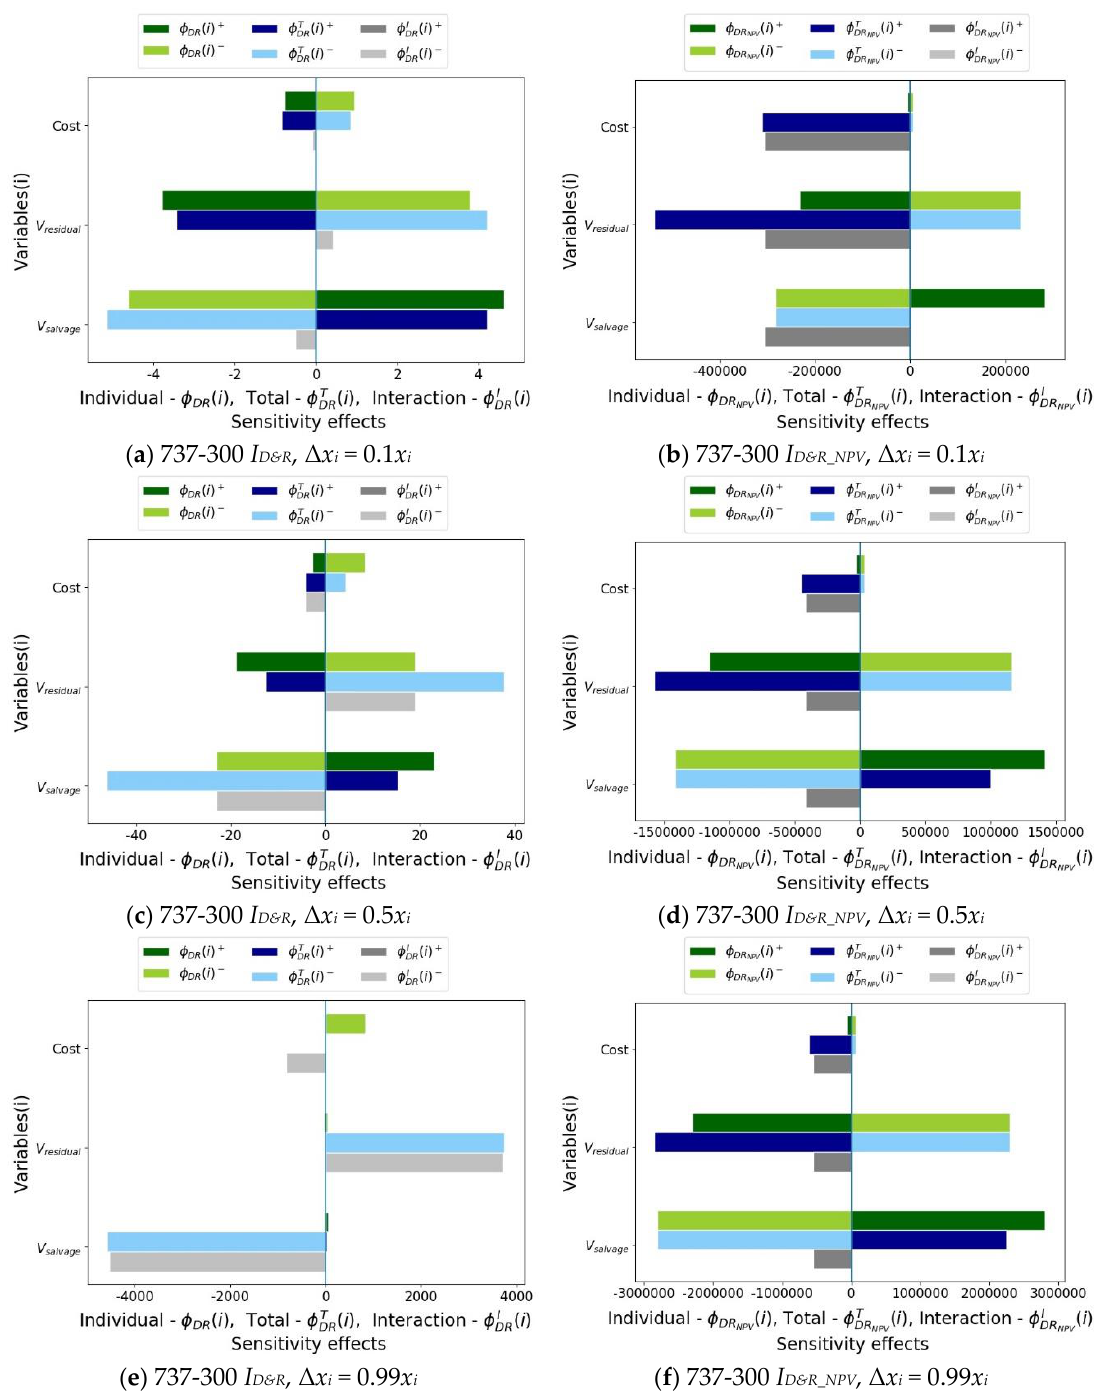
Figure 5. Sensitivity tornado diagram (737-300 disassembly and dismantling).